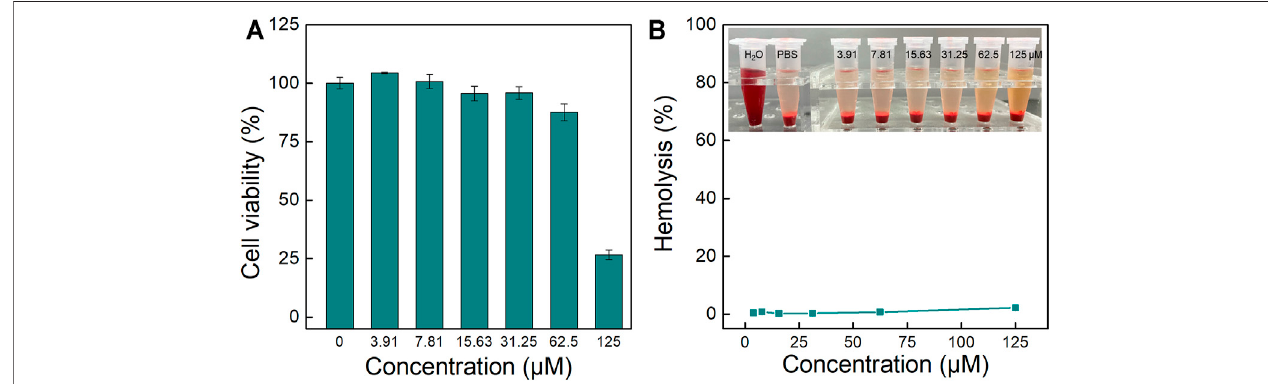
FIGURE 8 | (A) In vitro cytotoxicity analysis for TPA-PyOH upon incubation with A549 cells for 24 h; (B) Typical hemolytic analysis of TPA-PyOH against mice red blood cells. Inset: Representative images for the samples upon diverse treatments in hemolytic